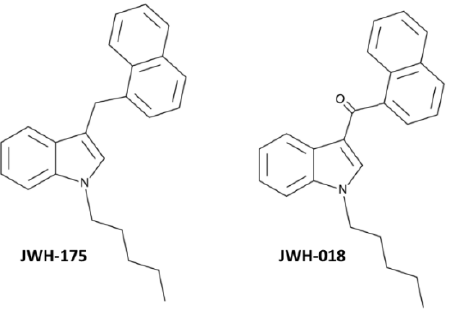
Figure 1. Chemical structures of JWH-175 (3-(1-naphthalenylmethyl)-1-pentyl-1H-indole) and JWH- 018 (1-naphthalenyl(1-pentyl-1H-indol-3-yl)-methanone) copied from the Cayman Chemical website (https://www.caymanchem.com, accessed date 17 April 2022).